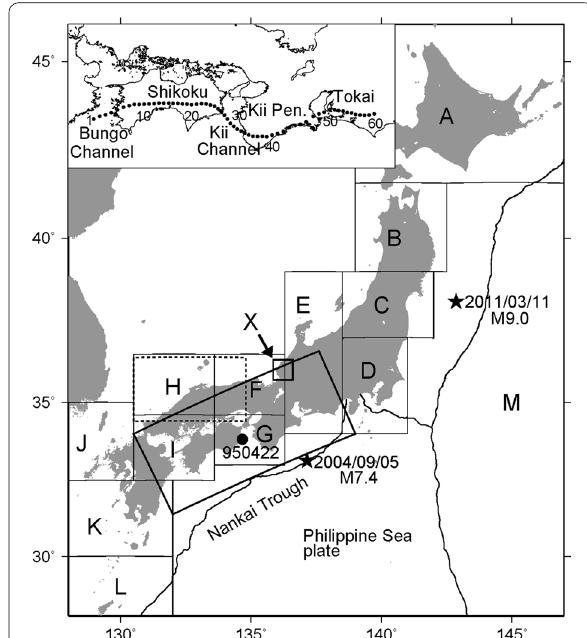
Fig. 1 Location map showing the study area and blocks used for steady-state velocity estimates. Solid curves indicate plate bounda- ries. The dotted rectangle encloses the Chugoku region. Labels A to M indicate blocks used for steady-state velocity estimation. Stars indicate earthquake epicenters, and the dot represents GNSS station 950422. The oblique rectangle is the Nankai Trough region shown in the inset map. Dots showing locations at ~ 25 km depth on the Nankai Trough subduction